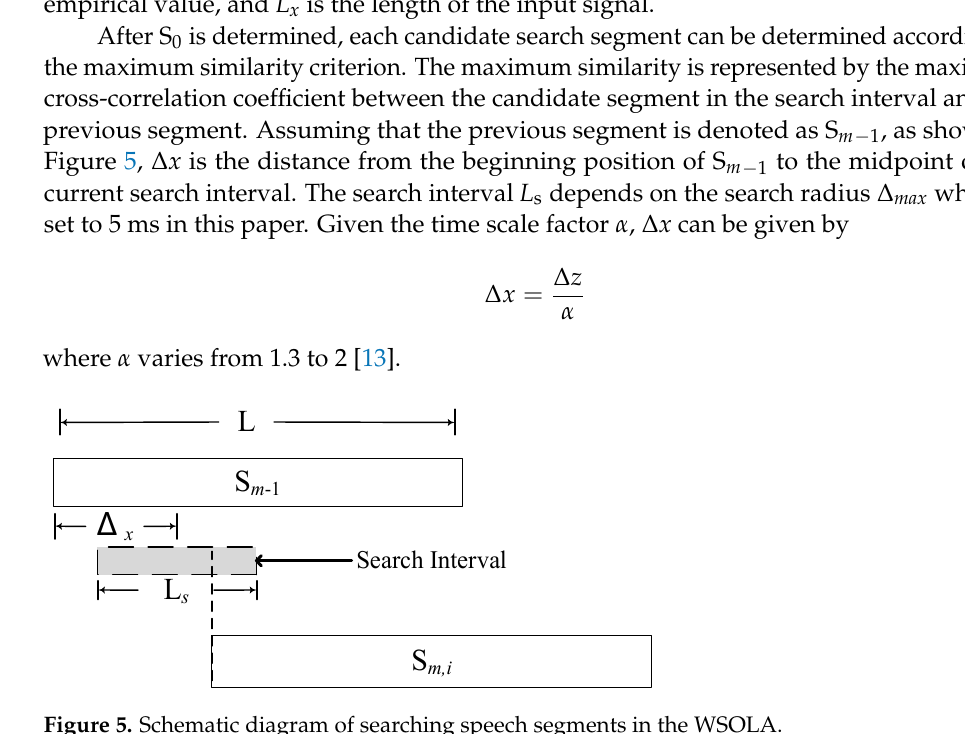
Figure 5. Schematic diagram of searching speech segments in the